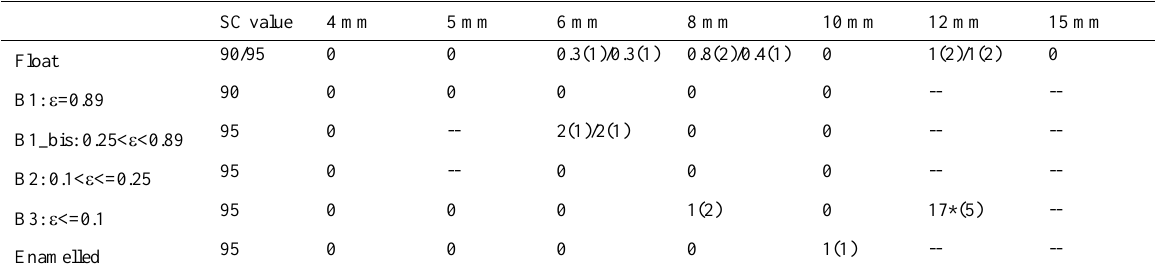
Table 9. Incidence value (%) and sample numbers () of NC data for SC (MPa) vs FB in TT with the proposed SC